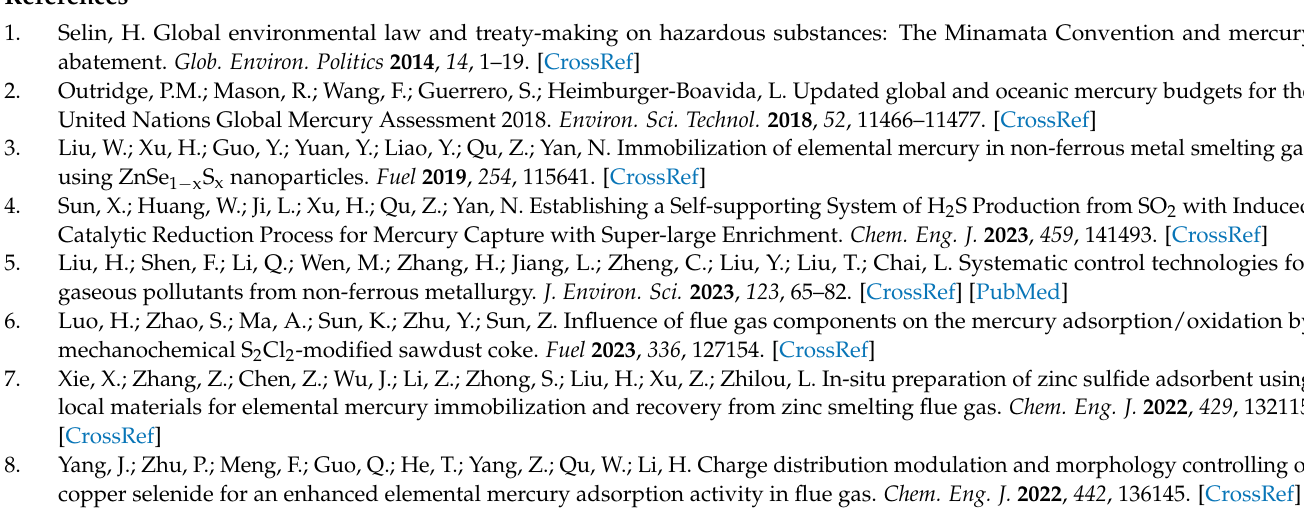
(b) Their phenomenon of Tyndall Effect. Figure S3. The SEM pictures of c-CuS. Figure S4. The effect of O 2 . Figure S5. The structure of configurations A, B, C, and D after mercury adsorption. Table S1. List of experimental conditions for Hg 0 capture. Table S2. Hg 0 adsorption capacities and rates